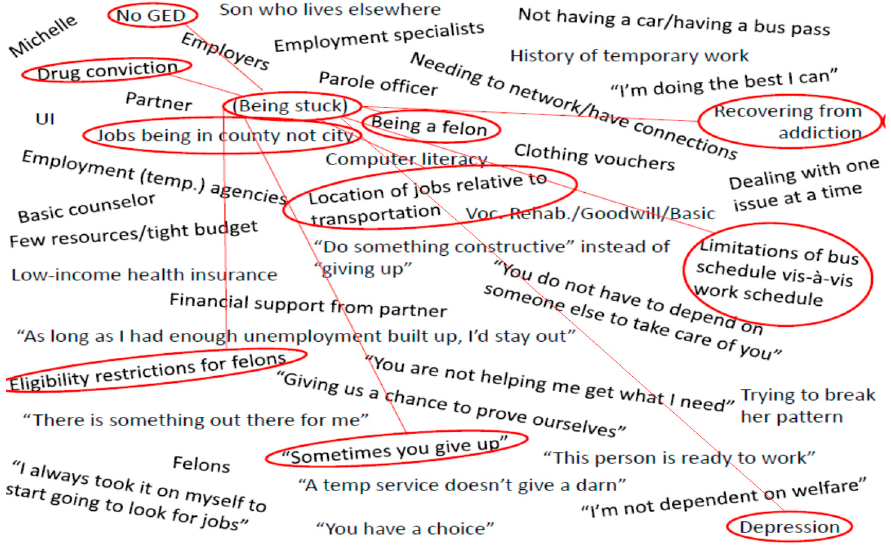
Figure 1. Relational situational map—Michelle.